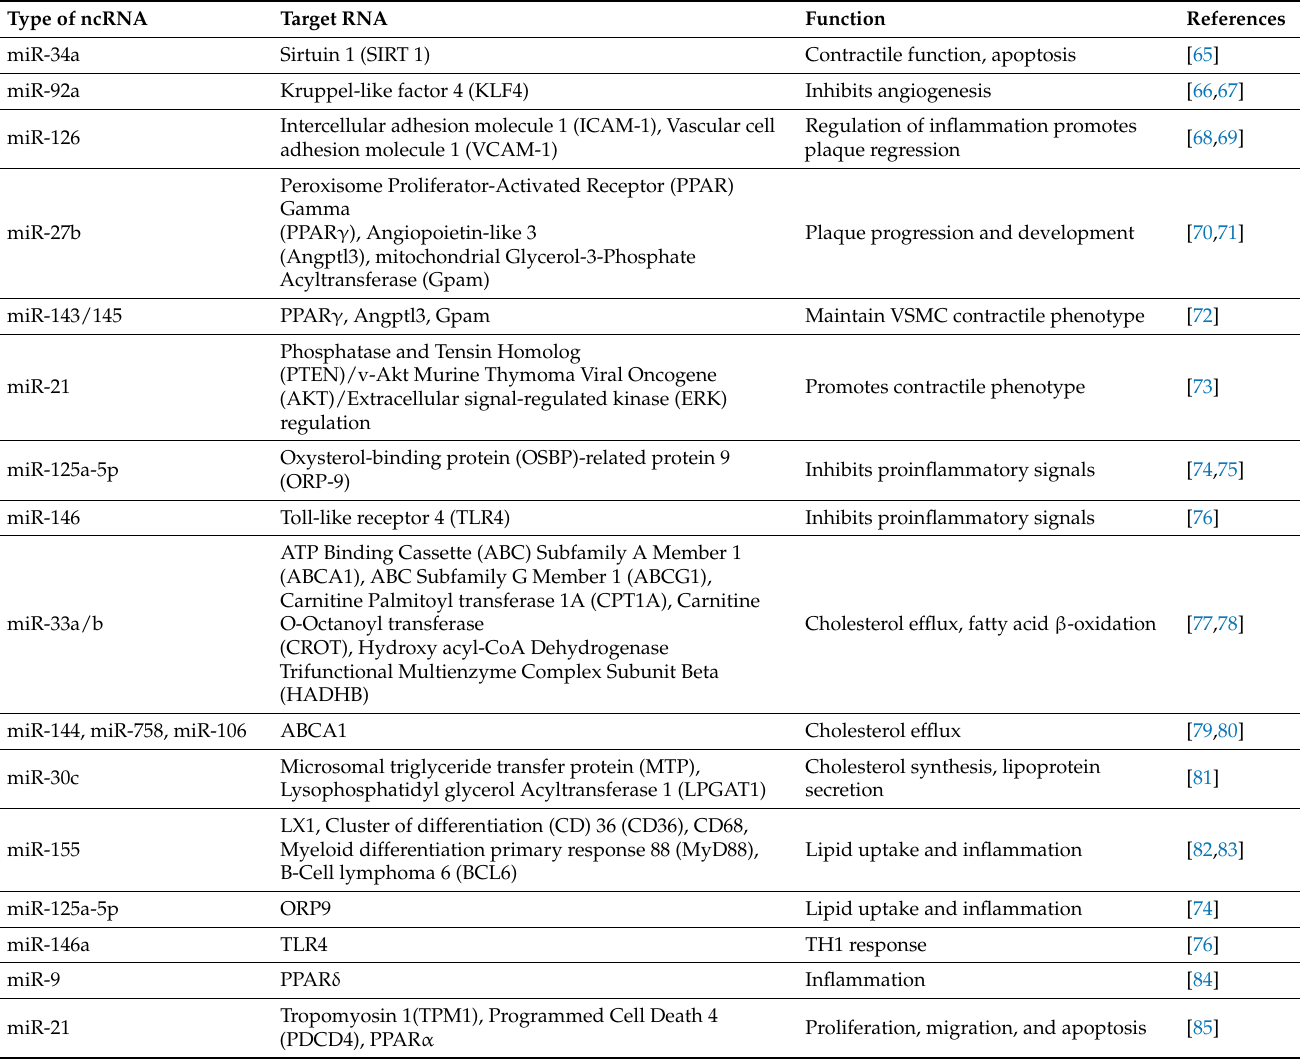
Table 1. miRNAs, their target, and